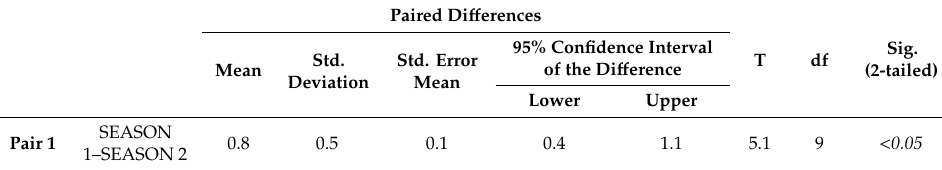
Table A15. Paired Samples